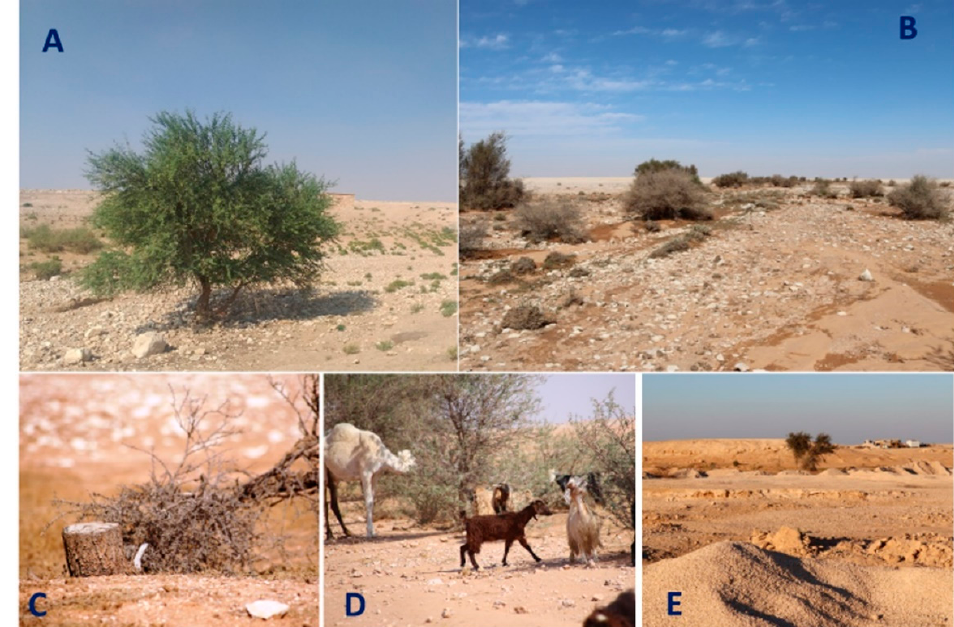
Figure 2. In the upper part an isolated tree of Vachellia gerrardii subsp. negevensis ( A ) and a repre- sentative image of the habitat where this species is found ( B ). In the lower part, the effects of the main threats on the species: cutting ( C ), unregulated grazing ( D ), and quarrying activities ( E ).